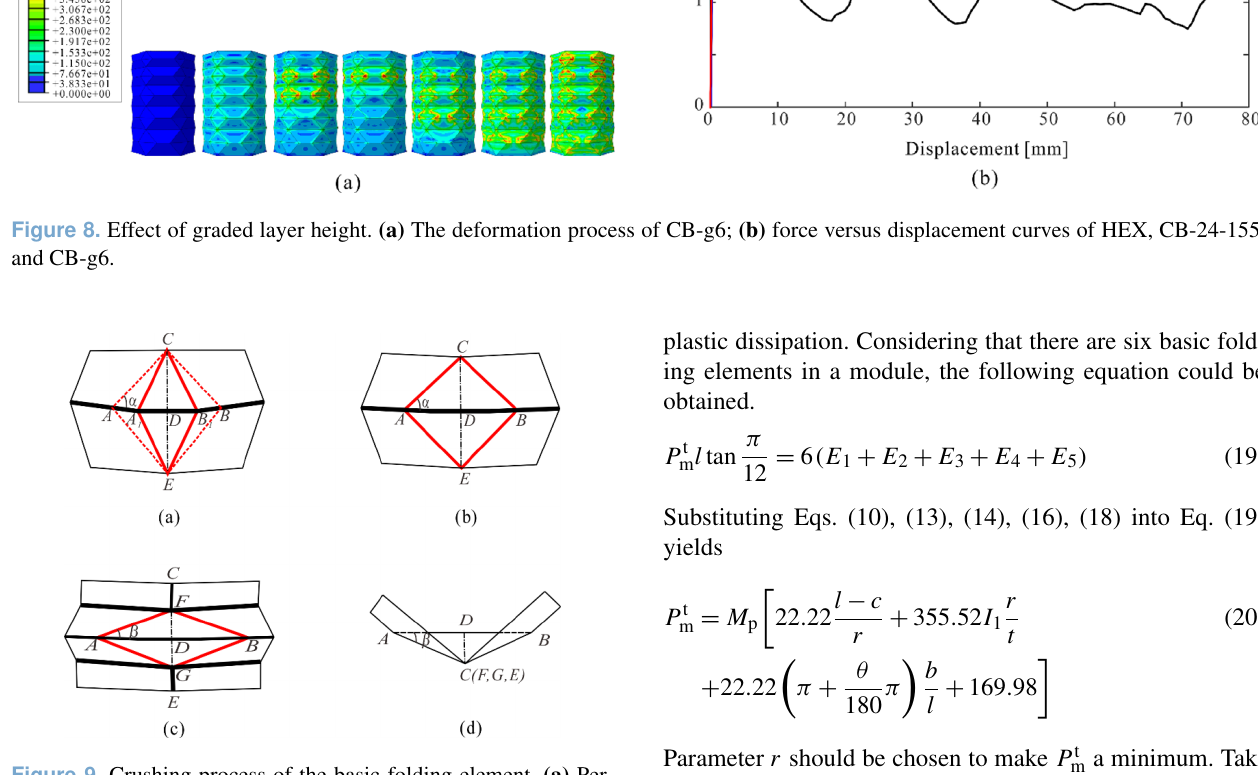
Figure 9. Crushing process of the basic folding element. (a) Per- spective view of the initial configuration; (b) perspective view of the configuration at the end of stage I; (c) perspective view of a par- tially crushed configuration at stage II; (d) top view of the entirely crushed